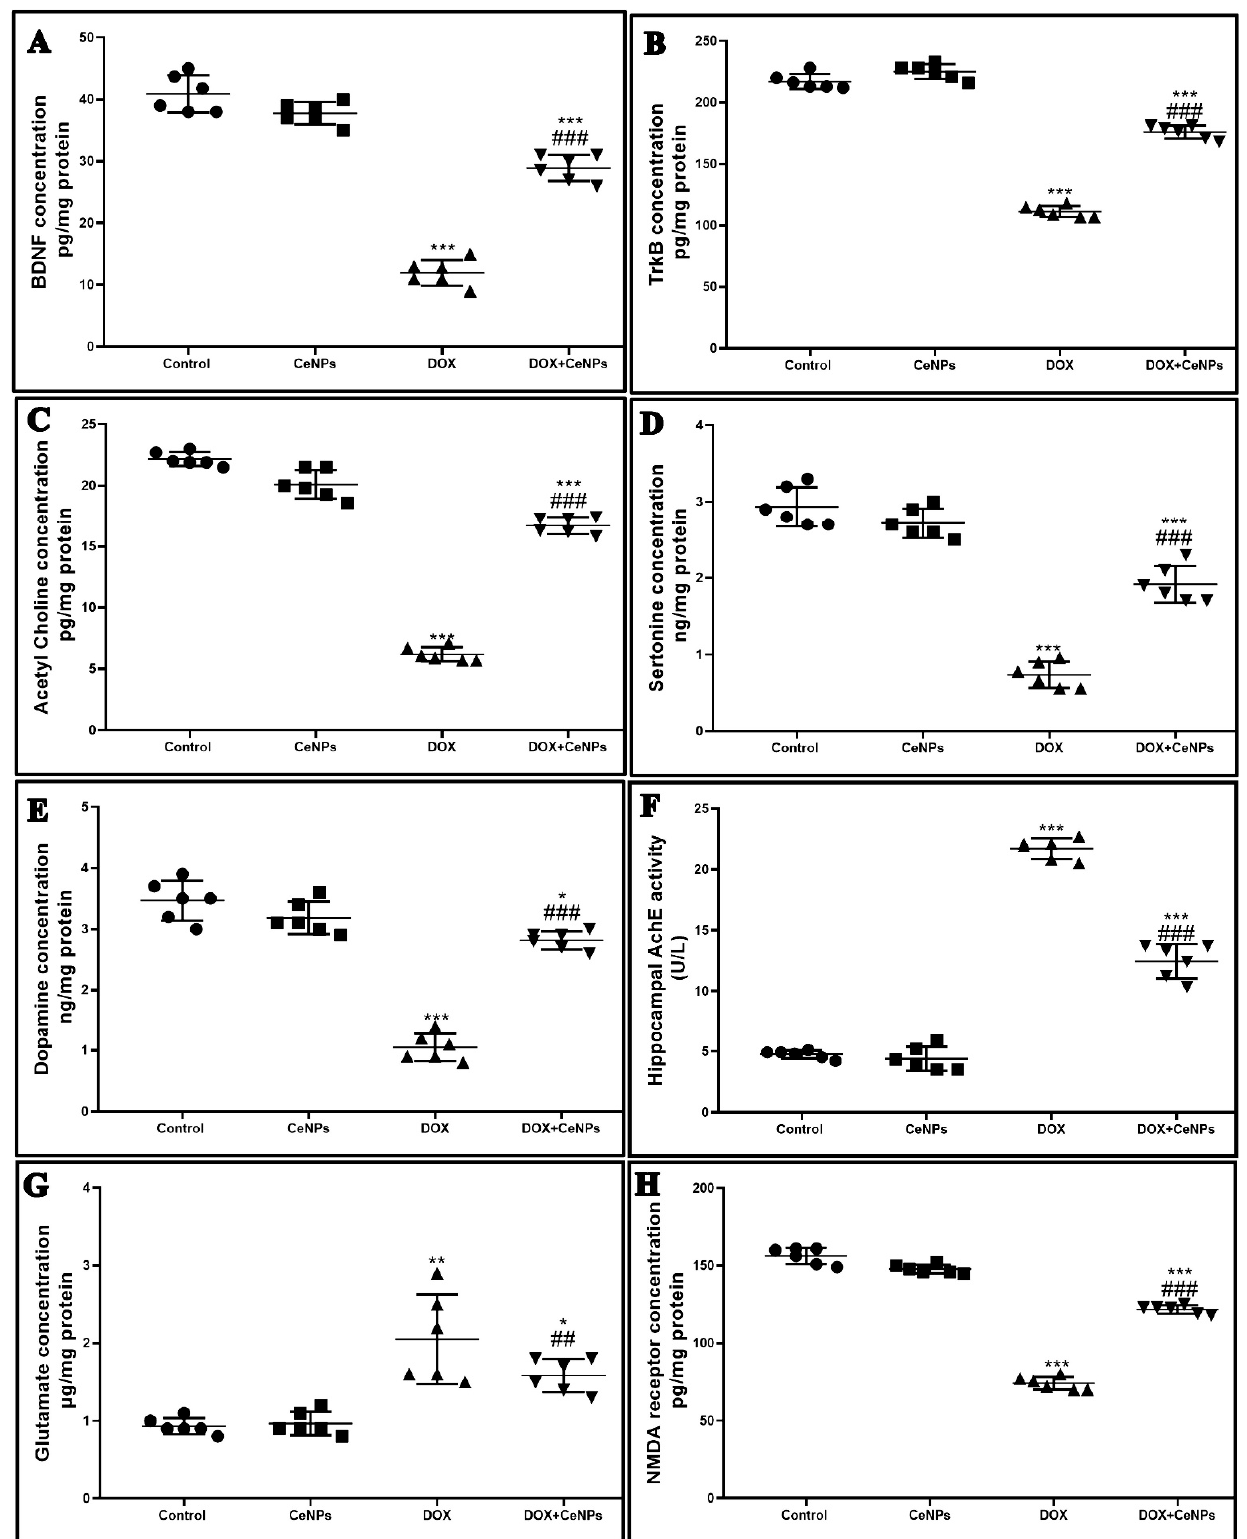
Figure 10. Effect of nanoceria treatment on protein expression of ( A ) BDNF, ( B ) TrkB, ( C ) acetylcholine, ( D ) serotonin, ( E ) dopamine, ( F ) AchE, ( G ), glutamate, and ( H ) NMDA receptor in different groups of rats. Data are presented as mean ± SD, *** p < 0.001, ** p < 0.01, and * p < 0.05 vs. control group, ### p < 0.001 and ## p < 0.01 vs. DOX group.